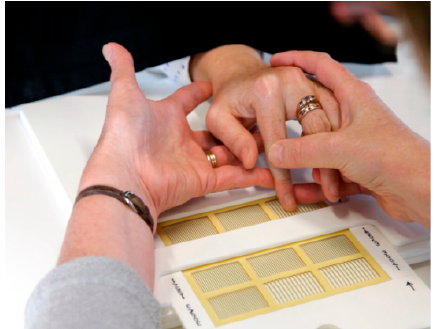
Figure 1. Tactile Discrimination Test (TDT) [35,36].